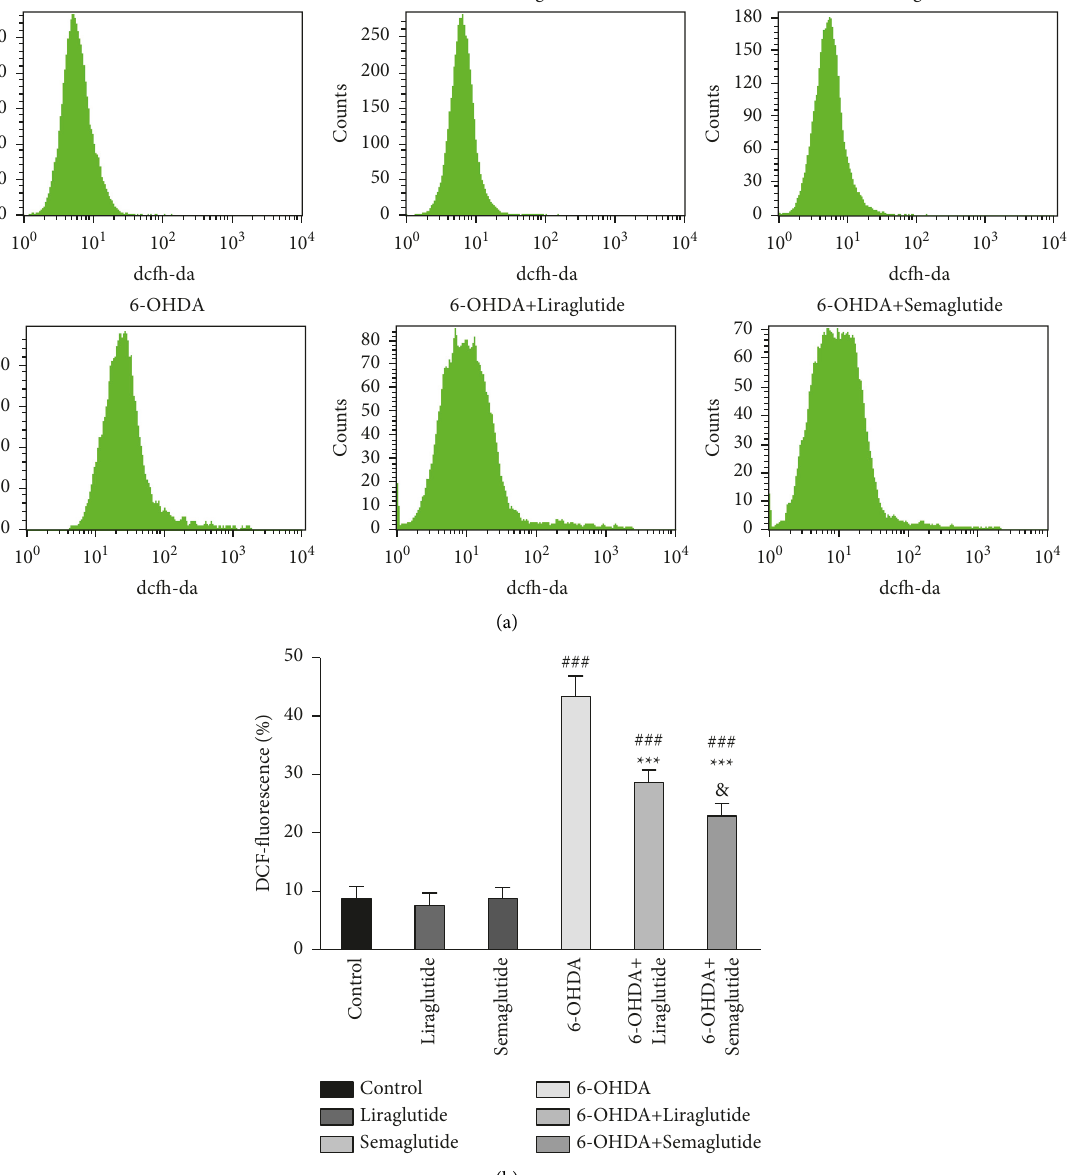
P 0 . 001 vs. 6-OHDA ∗∗∗ < ±